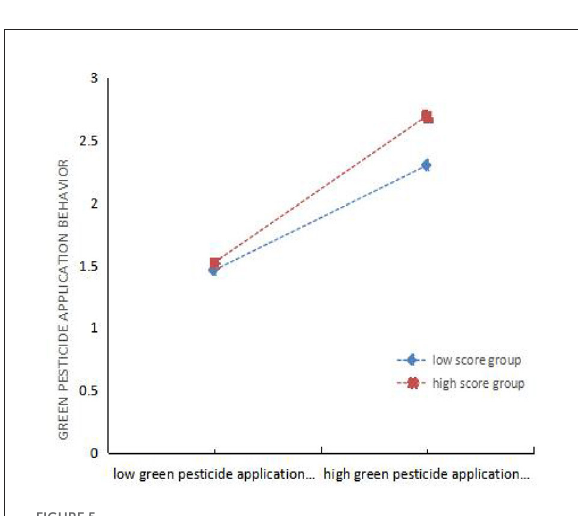
FIGURE5 Regulatory effect test of Market adjustment